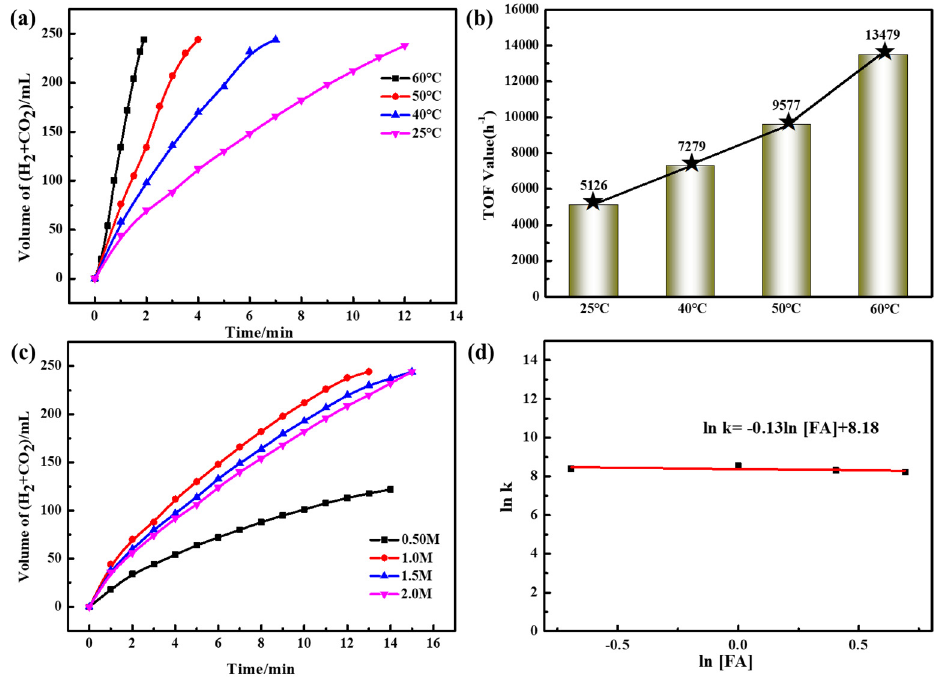
Figure 4. Gaseous generation during the decomposition of FA with respect to time in the presence of Pd/NH 2 -P-GC at different ( a ) reaction temperatures, ( b ) corresponding initial TOF values, ( c ) FA concentrations, and ( d ) reaction kinetics for the concentration variable. (Reaction conditions: n Pd /n FA =